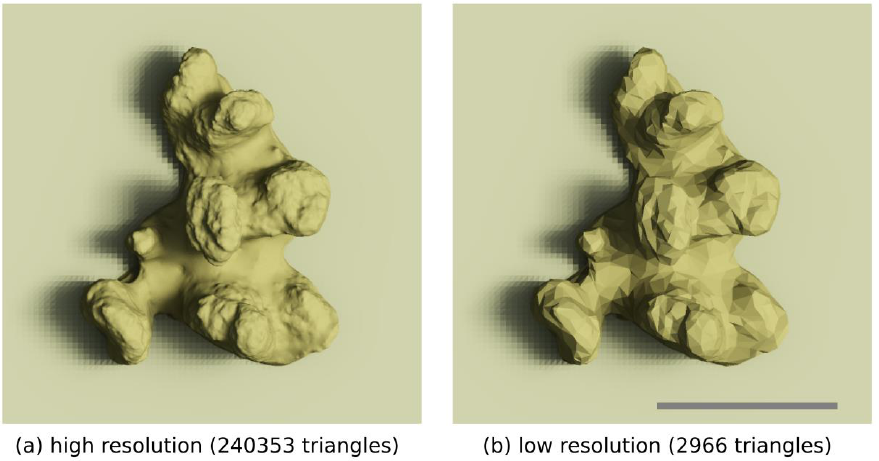
Figure 5. ( a ) High-resolution model versus; ( b ) low-resolution model of coral 35, scale bar is 5 cm.